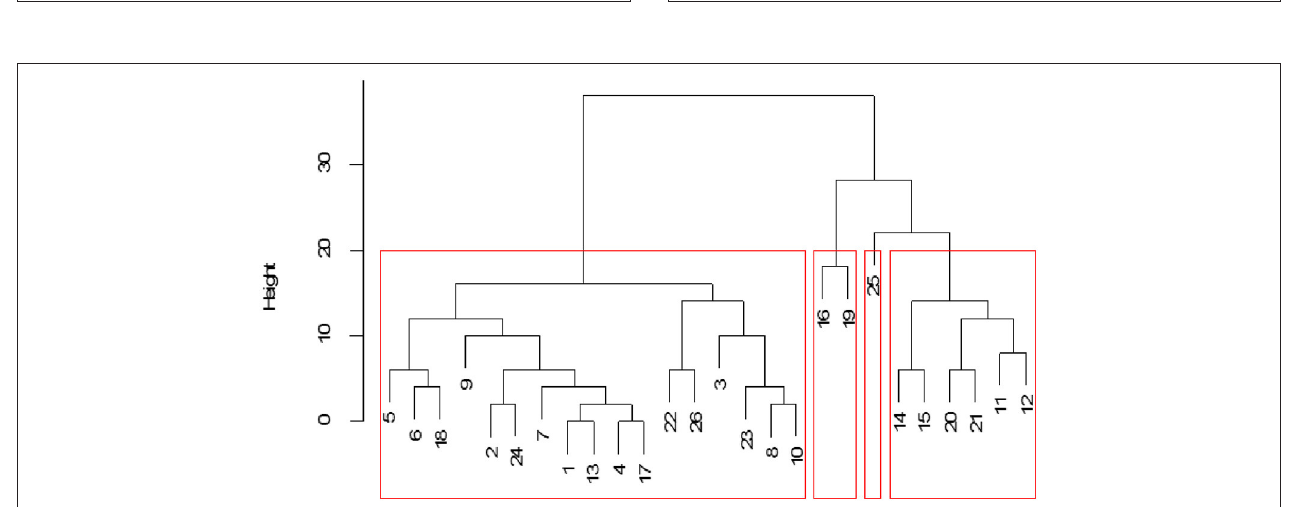
FIGURE 6 | Cattle market structural equivalence within the network. Numbers represent cattle market identification (ID), and red boxes indicate the cluster.